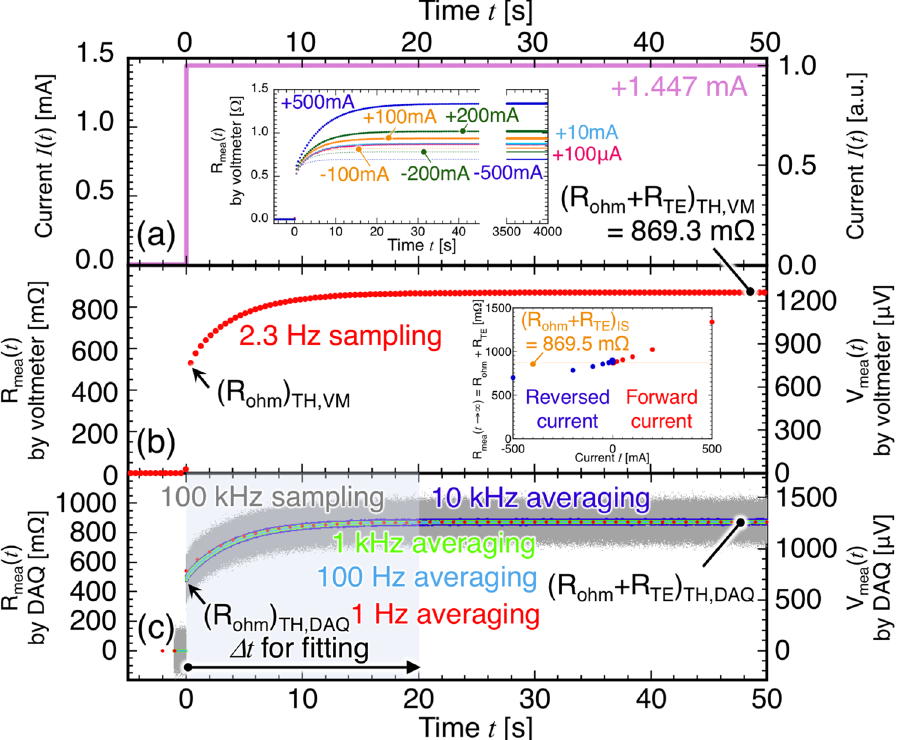
Figure 3. Time dependence of transient response for ( a ) direct current I ( t ), measured resistance R mea ( t ) and voltage V mea ( t ) by ( b ) a voltmeter, and ( c ) a DAQ system at a sampling rate of using 100 kHz and its averaging results without error bar for each averaging period, respectively. The insets of ( a ) and ( b ) show the time dependence of R mea ( t ) at each current and current dependence of R mea ( t → ∞),